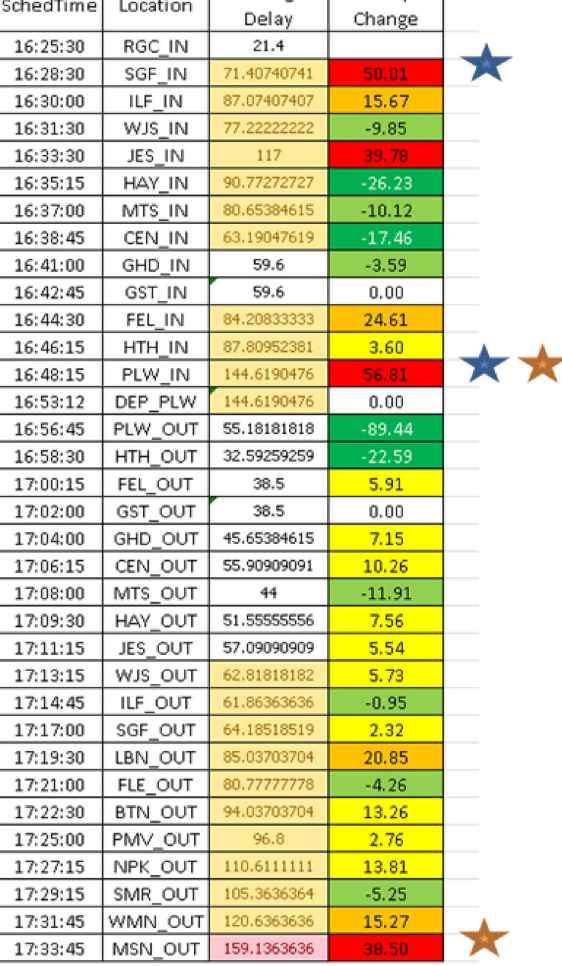
Fig. 5 Formatted table of average delays for the 155 metro train